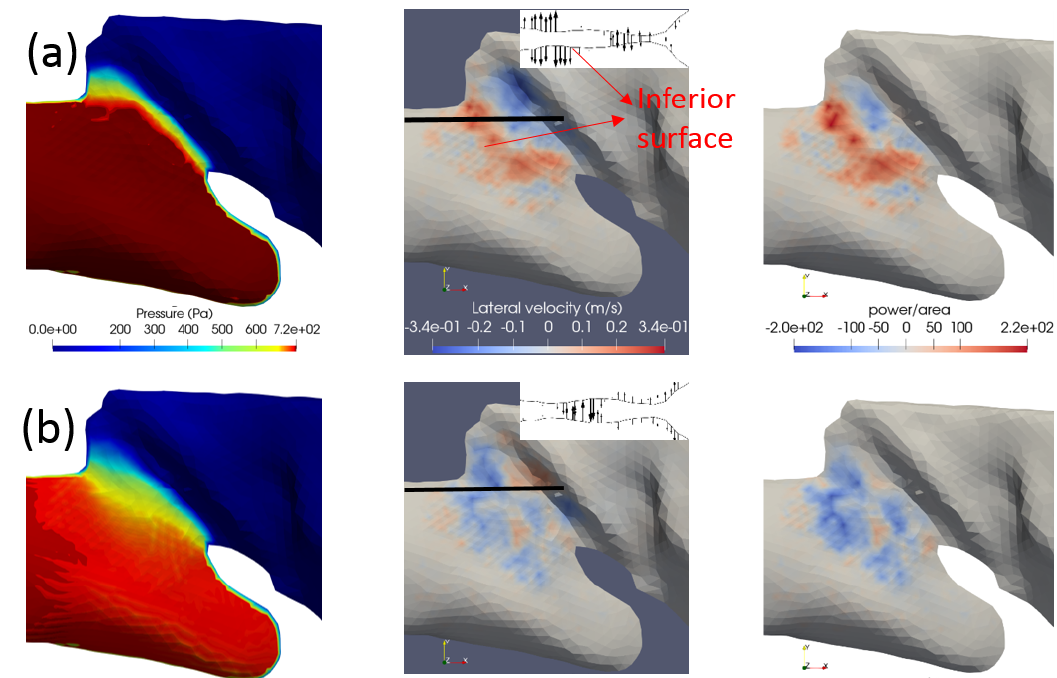
Figure 6. Contours on the vocal fold surface for Sample 3 at ( a ) t = 1.5 cs (VF closed) and ( b ) t = 1.6 cs (VF open). Left to right: pressure contour, lateral velocity w , power per unit area on the vocal fold surface. The inset on the center picture shows the vocal fold profile and the velocity vectors in the cut plane indicated by the thick bar in the